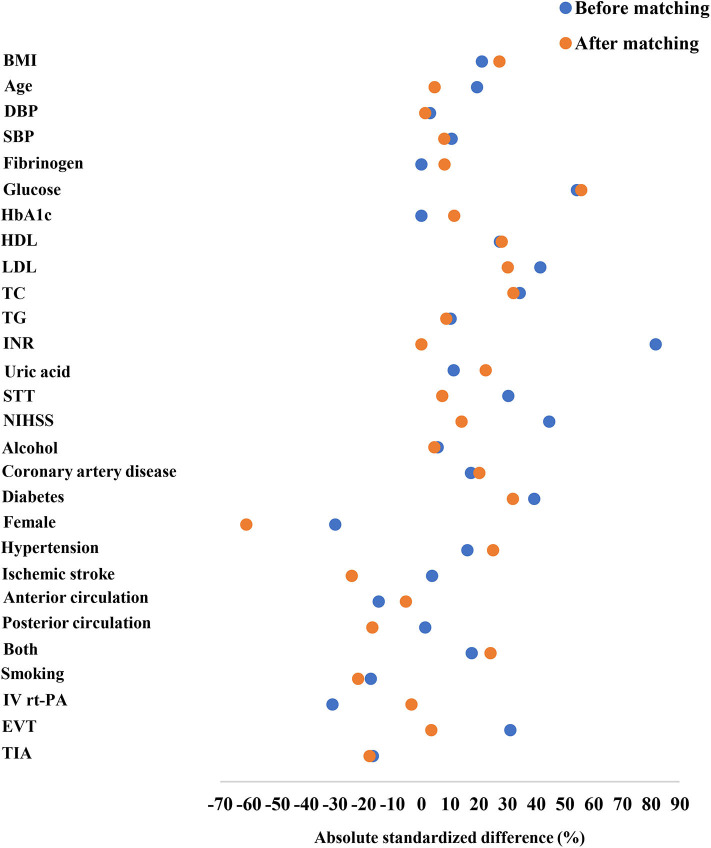
Absolute standardized differences in the baseline characteristics of AIS patients after recanalization therapy before and after 1:1 propensity-score matching were shown. The Y axis showed the baseline characteristics, and the scatterplot represented the status before or after matching.